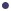
Scatter plots of five water parameters measured by Citizen Science Leaders (CSLs) and the Environmental Protection Department of Hong Kong (EPD) between 2014 and 2015.The CSL monitoring sites (represented by solid-filled symbols, ●
◆) were 50 m or less apart from EPD monitoring sites (represented by hollow symbols, ○
◇).